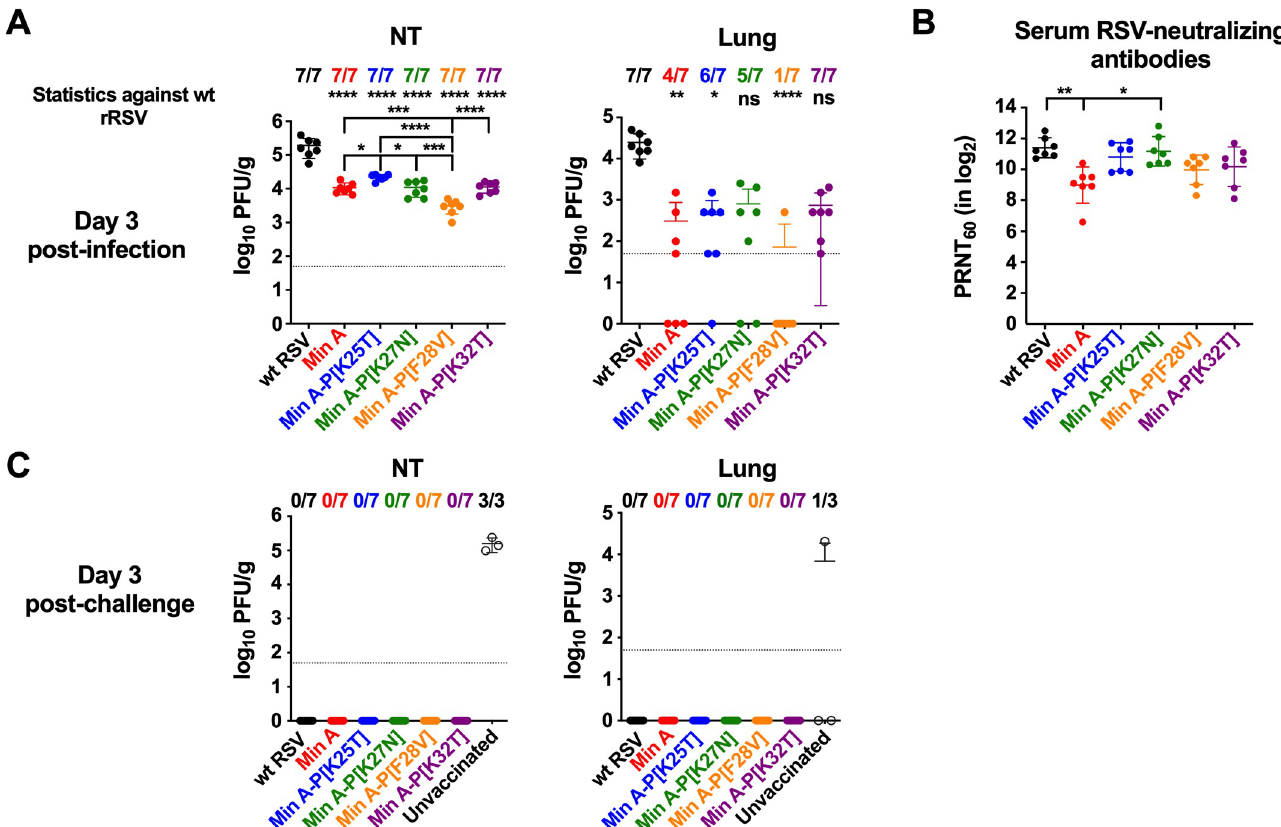
Fig 5. Replication, immunogenicity, and protective efficacy of the Min A-derived viruses in hamsters. Groups of 14 six-week old golden Syrian hamsters were inoculated intranasally with 10 6 PFU of the indicated virus per animal. Three additional hamsters were left uninfected as controls. (A) Replication of wt RSV, Min A and Min A-derivatives in the nasal turbinates (NT) and lungs harvested at day three pi from seven hamsters per group was evaluated by plaque assay as described in Materials and Methods and expressed as PFU/g of tissue. The limit of detection, 50 PFU/g, is indicated by a dotted line. (B) Sera were collected at day 24 pi from seven hamsters per group and the 60% plaque reduction neutralizing antibody titers (PRNT 60 ) were determined. (C) At day 27 pi, seven hamsters per group and the three control hamsters were challenged by intranasal inoculation with 10 6 PFU of wt RSV. Three days after challenge, replication of wt RSV was evaluated in the NT and lungs by plaque assay. In each graph each hamster is represented by a colored circle and the median value and standard deviation are shown. The number of hamsters with replicating virus is indicated. In panel A, statistical differences indicated at the top of each graph are in comparison to wt RSV while differences between Min A and Min A derivatives are indicated in brackets. In panel B, all statistical differences are indicated by brackets ( � p � 0.05; �� p � 0.01; ��� p � 0.001; ���� p � 0.0001).